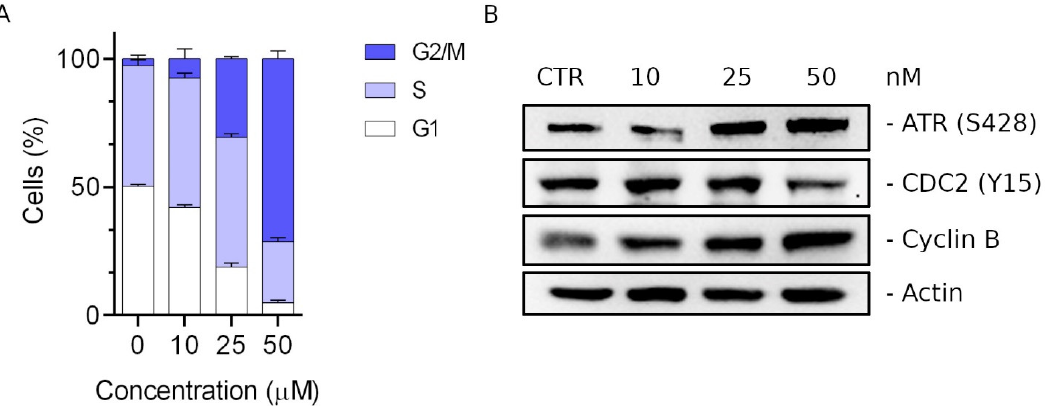
Figure 4. (Panel ( A )) Quantitative analysis of cell cycle phase distribution in HeLa cells after a 24 h treatment with 3d , at the concentrations of 10, 25 or 50 nM. Cells were stained with PI to analyze the DNA content by flow cytometry. Data are presented as means of three independent experiments ± SEM. (Panel ( B )) Effects of compound 3d on cell cycle regulatory proteins and DNA damage check- point proteins. HeLa cells were treated for 24 h with the indicated concentration of 3d , and expres- sion of ATR, cdc2 (Y15) and cyclin B was detected by Western blot analysis. We then evaluated by Western blot analysis the effects of 3d on the expression of several proteins regulating the mitotic checkpoint. When damage to the mitotic spindle occurs, the mitotic spindle assembly checkpoint is activated, causing an accumulation of cyclin B and the dephosphorylation of cdc2 [67,68]. We found (Figure 4B) that treatment with 3d induced an increase in cyclin B expression and, at the same time, a significant reduction in cdc2 phosphorylation (Y15). The prolonged arrest in metaphase induces the activation of a DNA damage signal cascade that involves primarily ATR kinase, which becomes phosphorylated at Ser428. As shown in Figure 4B, we found a considerable increase in ATR phosphorylation (Ser428) [69], suggesting that 3d induced the activation of the DNA damage signaling response with consequent accumulation of cyclin B and a block of cells in the G2/M phase. 2.2.5. Compound 3d Induced Apoptosis in HeLa Cells through Mitochondrial Depolari- zation With the aim of evaluating the type of cell death induced by the treatment of com- pound 3d , we treated HeLa cells with different concentrations of 3d, and, after 24 or 48 h, we labeled the cells with both annexin-V conjugated with FITC and propidium iodide (PI). The cells were then subjected to flow cytometric analysis, and the results are shown in Figure 5. Compound 3d induced, in a concentration- and time-dependent manner, apoptosis in the treated cells. The effect was evident at 25 nM and stronger still at 50 nM. With 3d at 50 nM and at long incubation times, a fair percentage of cells (about 25%) be- came necrotic, being positive only for PI (A − /PI + ).